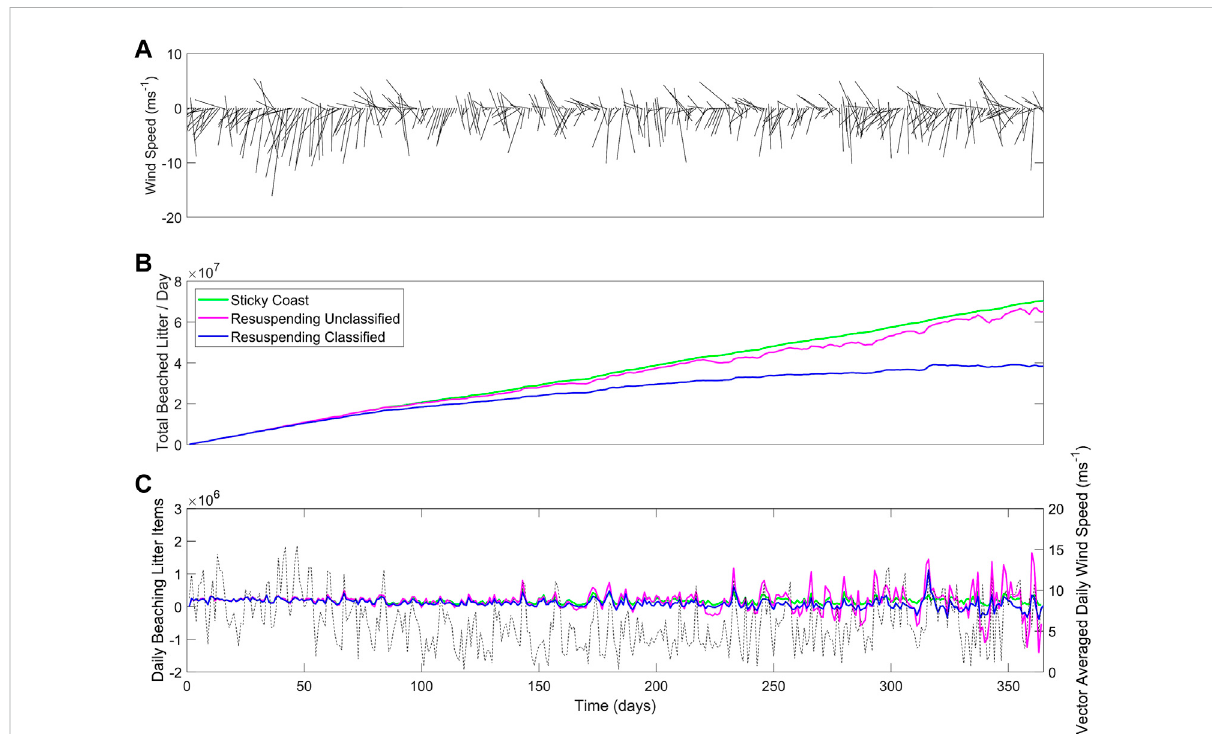
FIGURE 4 (A) Avectortimeseriesofthedailyaveragewindspeed(ms − 1 )anddirection(fromwhichthewindblows)acrossthemodeldomain. (B) Totaldaily beaching plastic litter items at 3% wind drift and (C) the number of daily beaching plastic litter items at 3% wind drift for the sticky coastline (solid green line) the resuspending unclassi fi ed coastline (solid black line) and the resuspending classi fi ed coastline (solid pink line). The vector averaged daily wind speed (ms − 1 ), is represented by the dotted black line. The model simulation ran from 1st January to 31st December